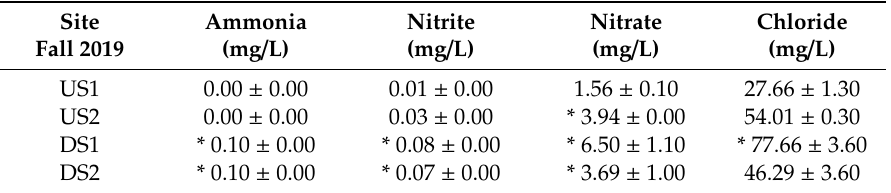
Table 2. Summary of total ammonia, nitrite, nitrate, and chloride concentrations at sites where fish were collected during this study in fall 2019. Data are presented as mean ± SEM ( n = 3 per site). Concentrations were only available from the fall 2019 sampling period. The values show that there were increased, measurable amounts of nitrogenous compounds and chloride downstream from the MWWTP. An asterisk indicates a significant di ff erence in concentration compared to US1 (Dunnett’s multiple comparisons test, p < 0.05). US1, upstream 1; US2, upstream 2; MWWTP, municipal wastewater treatment plant; DS1, downstream 1; DS2, downstream